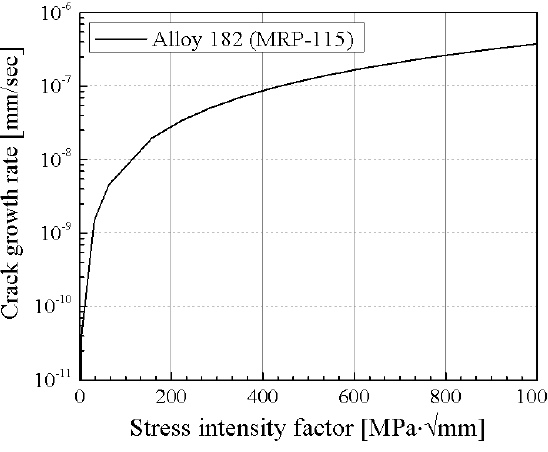
Figure 13. SCC growth rate curve for Alloy 182 presented in MRP-115.